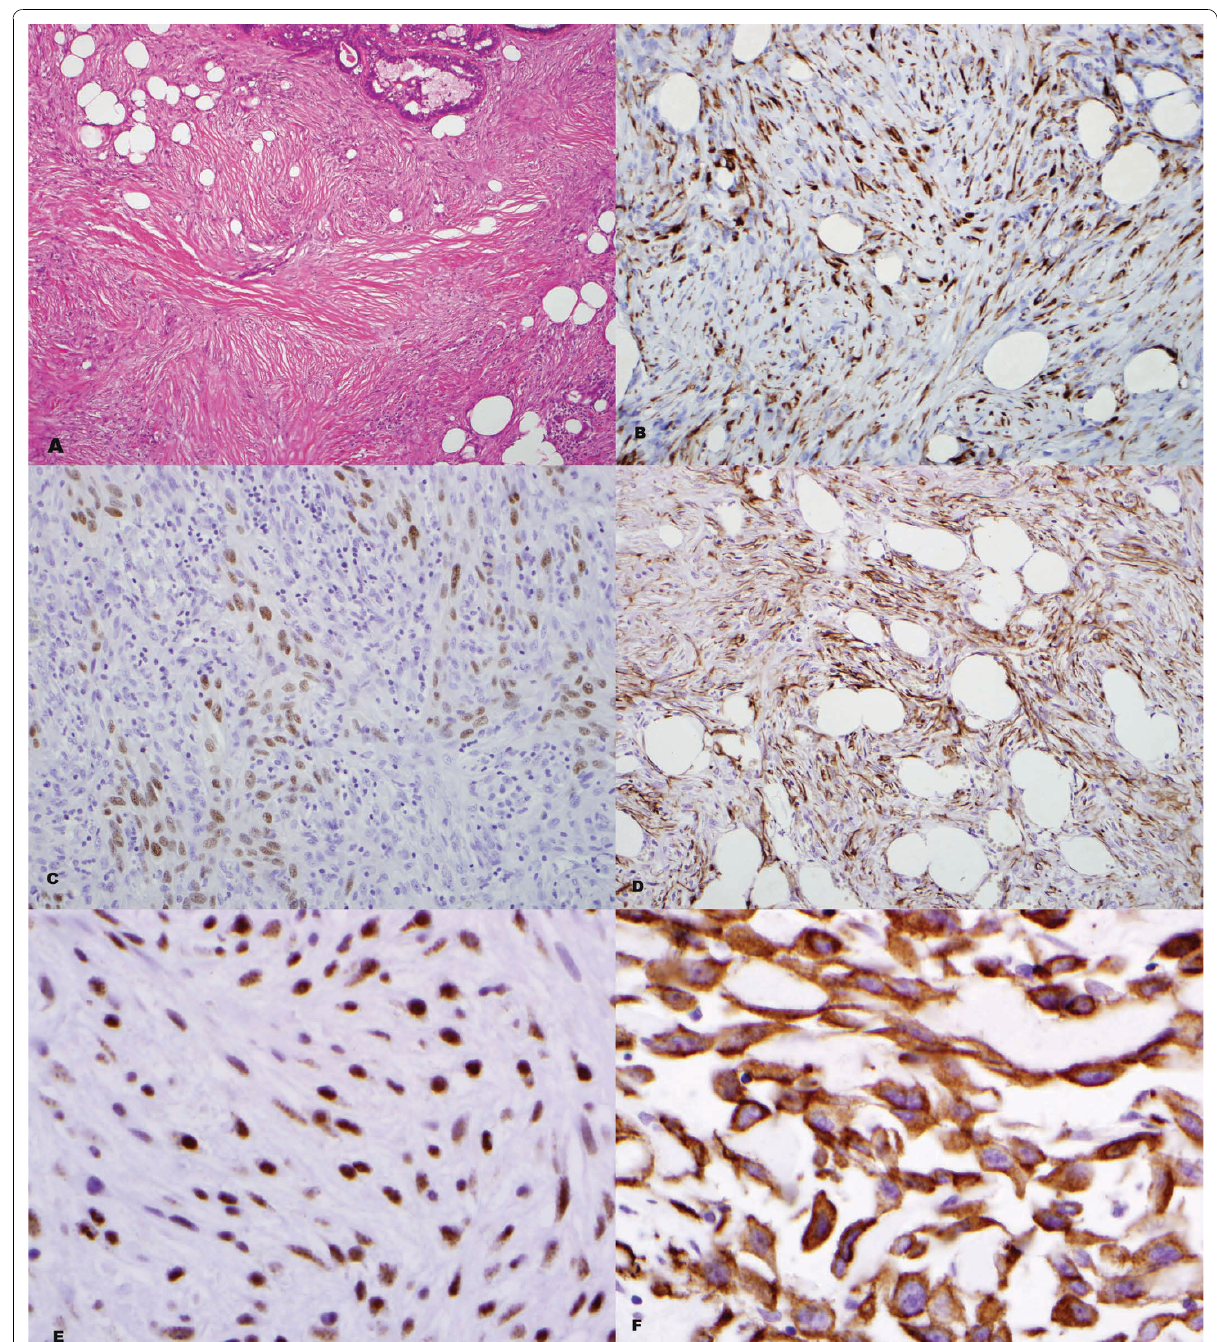
Figure 4 High grade spindle carcinoma (A; H&E - 40×) with positive staining for OSCAR (B; 40×), p63 (C; 40×), WS-KER (D; 40×), SNAIL (E; 60×) and EGFR (F; 60×)